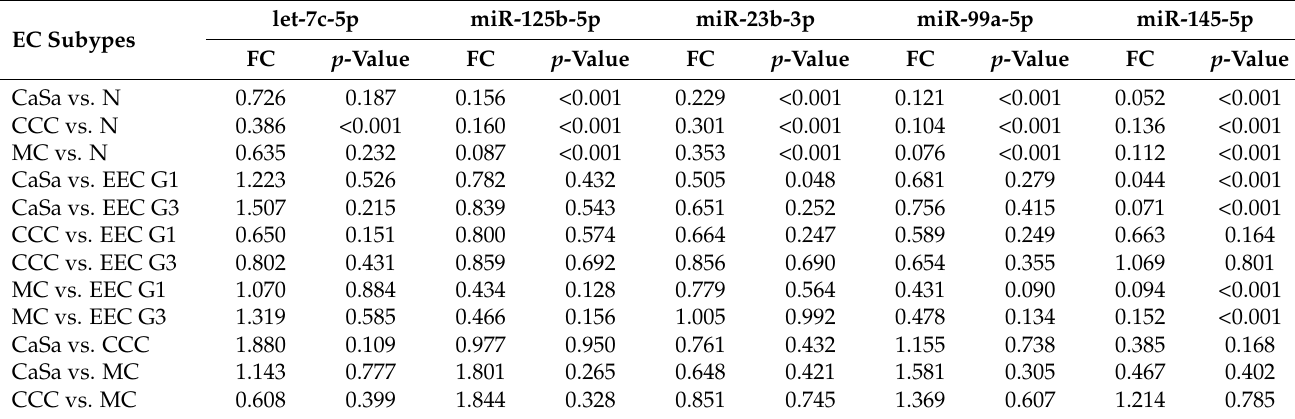
Table 2. Rare subtypes of endometrial carcinoma: expression of miRNAs selected for discrimination of endometrioid endometrial carcinomas according to different grades.